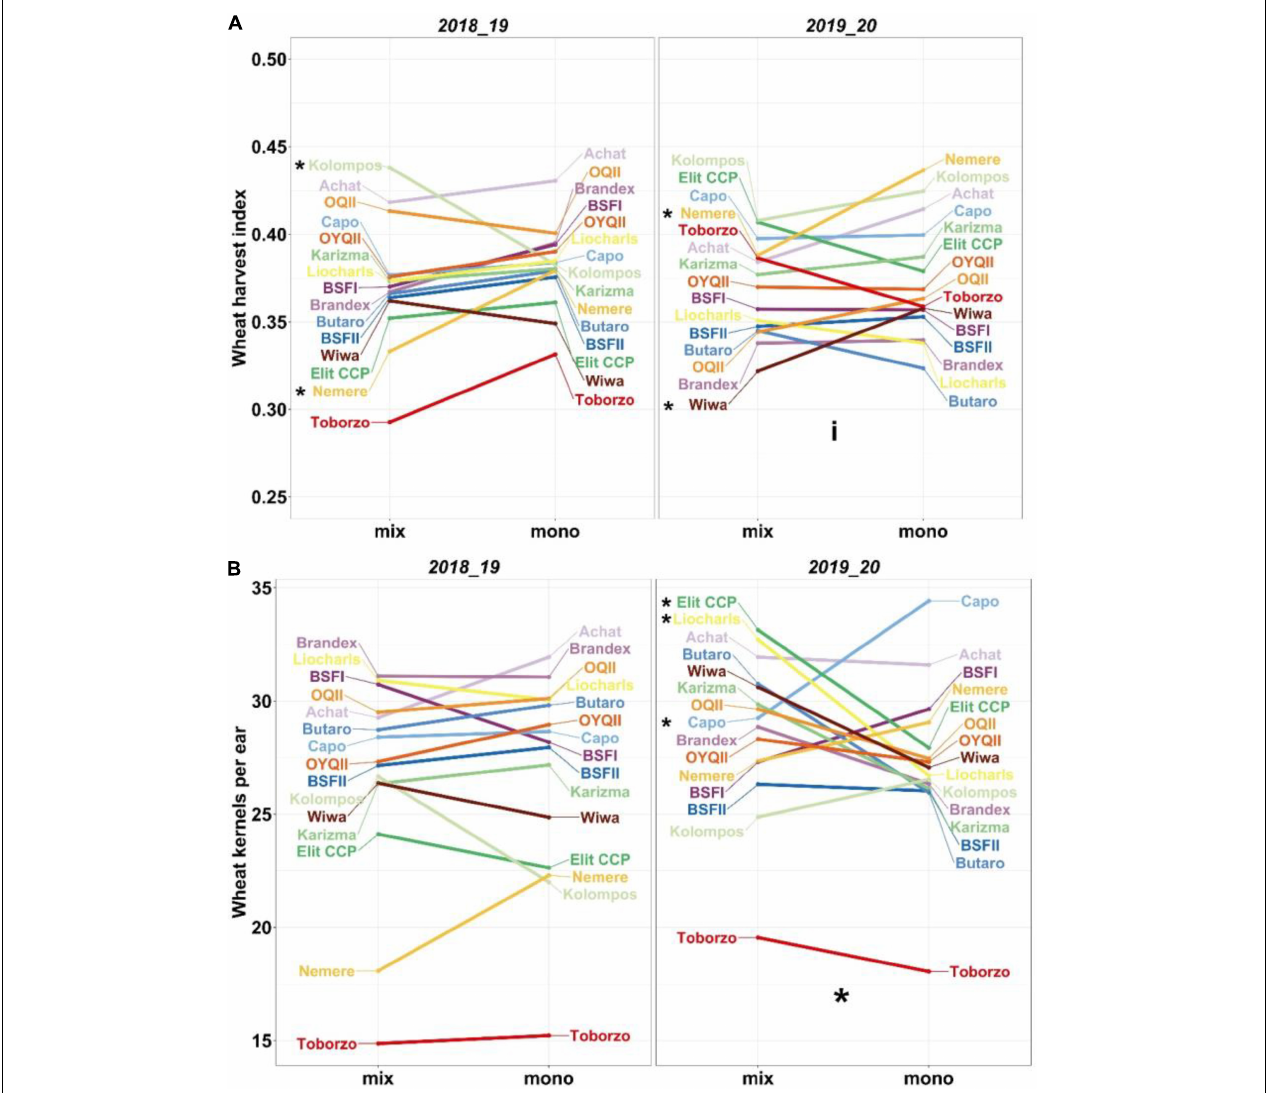
FIGURE 8 | Interaction plots for (A) harvest index and (B) kernels per ear. Estimated marginal means from linear mixed effect models are plotted. Small stars indicate significant differences in entries between systems and large stars between systems across entries, and “i” indicates significant interactions at P < 0.05 estimated from mixed models with pairwise comparison and Holm